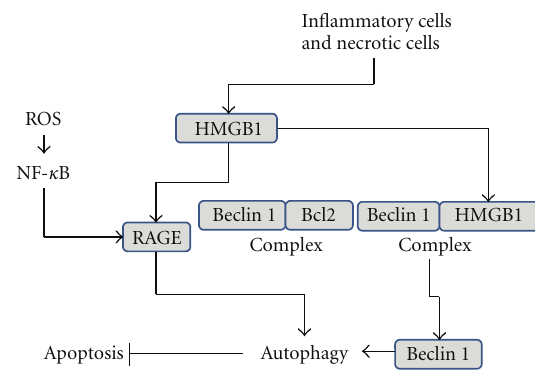
Figure 2: HMGB1 and RAGE induce autophagy. HMGB1 is released by necrotic and inflammatory cells. Expression of RAGE is induced by ROS in a NF-kB-dependent manner. On one hand, HMGB1 induces autophagy by its direct binding to the RAGE. On the other hand, HMGB1 induces autophagy by interacting with Beclin 1 which results in dissociation of Beclin 1-Bcl2 and subsequent induction of